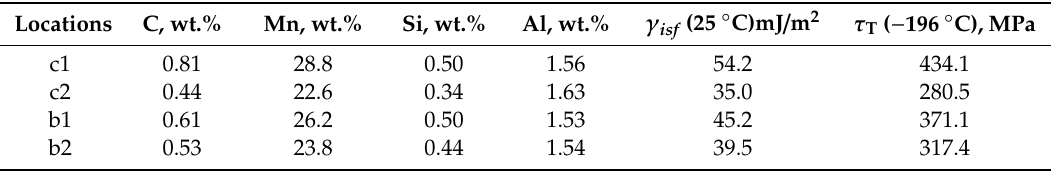
Table 4. WDS quantitative analysis results of detected micro zones and the corresponding γ isf , τ T of CGHAZ and BM. Locations C, wt.%